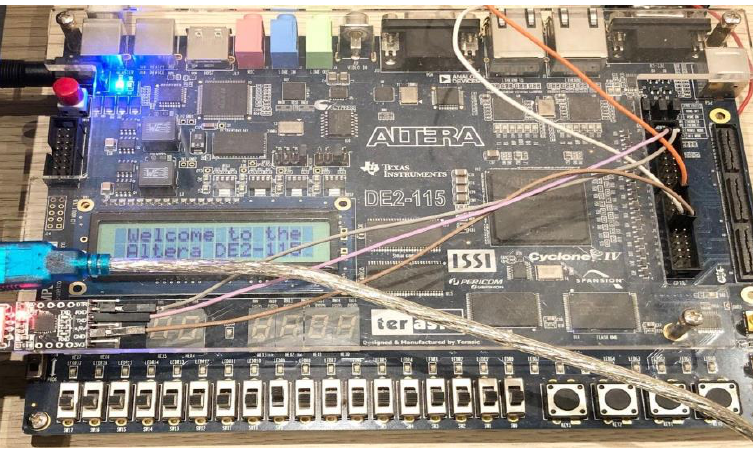
Figure 17. The ALTERA FPGA Kit of the proposed system.